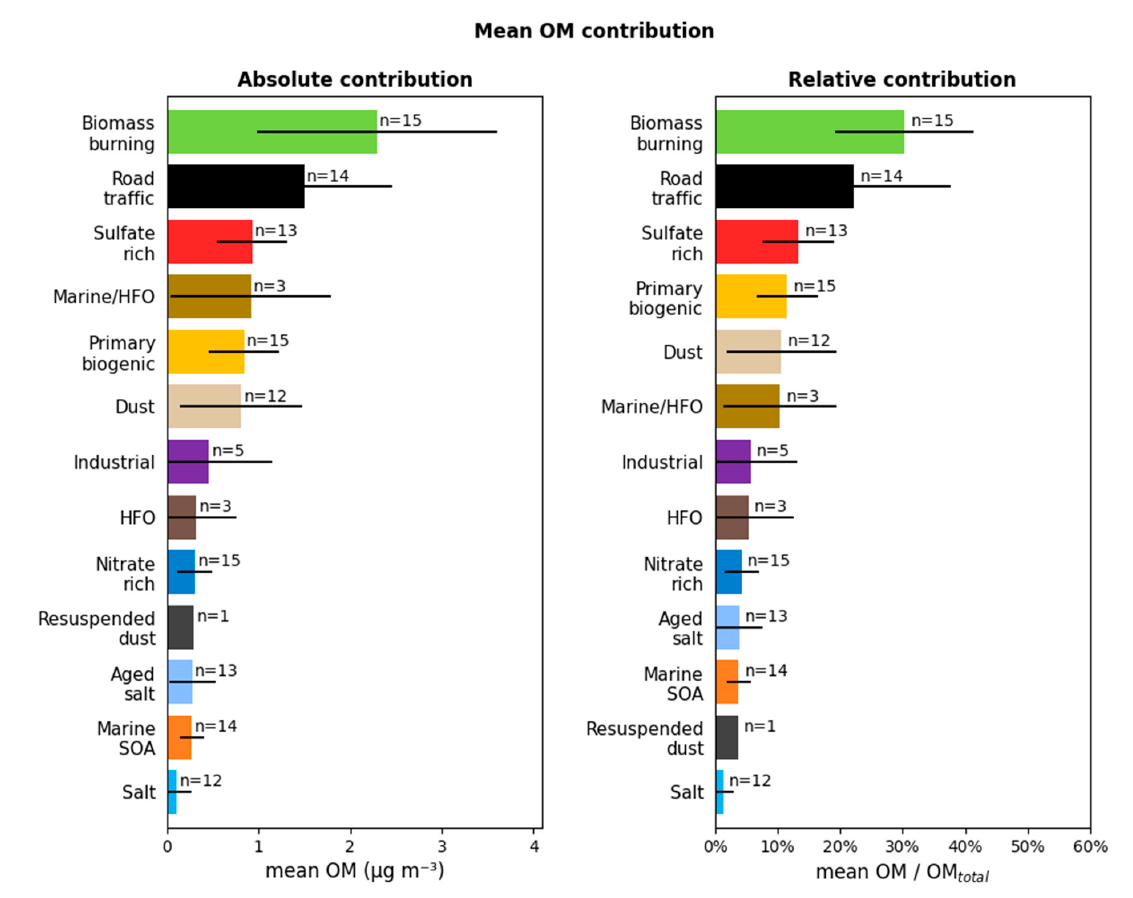
Figure 11. Average and standard deviation of various source contributions to total OM in French urban environments ( n = number of sites where the given source profile is defined in the PMF analysis). Left: average concentrations (in µg/m3), Right: average relative contribution (%). Adapted from work described by Weber et al. [42].